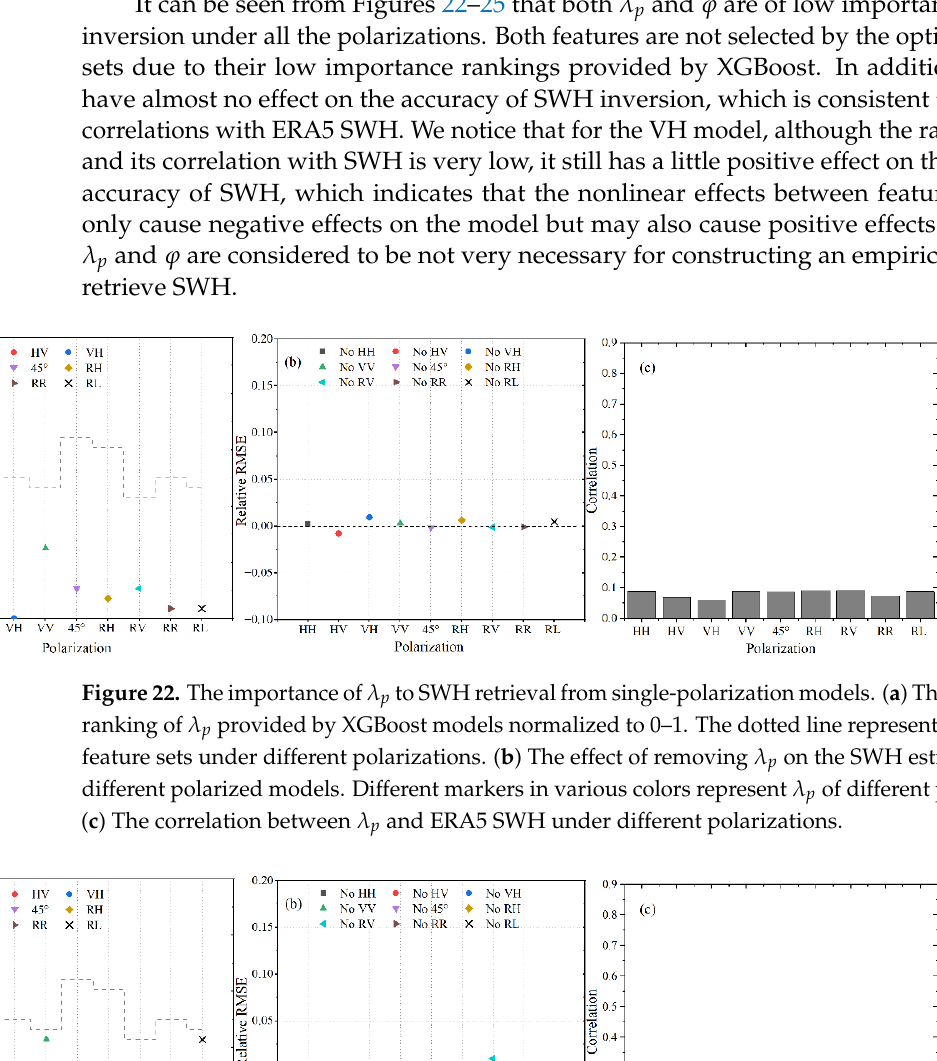
Figure 21. The importance of λ c /β to SWH retrieval from combined-polarization models. ( a ) The importance ranking of λ c /β provided by XGBoost models, normalized to the range of 0 – 1. ( b ) The effect of removing λ c /β on the SWH estimation from different polarized models. The red pentagrams represent the relative RMSE corresponding to the removal of λ c /β -terms in the combined-polariza- tion models.